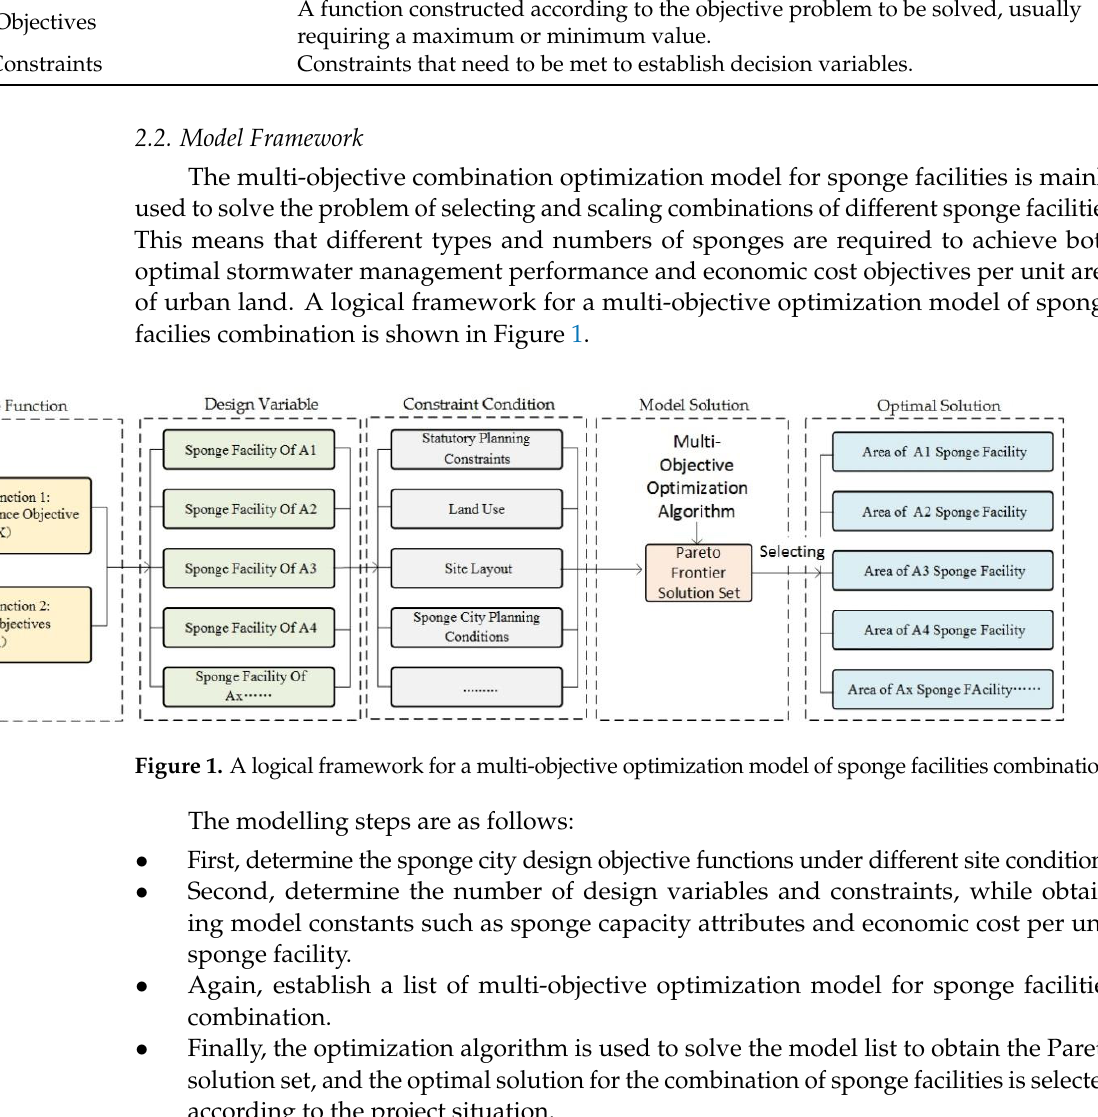
95 Table 1. Components of a multi-objective optimization model.